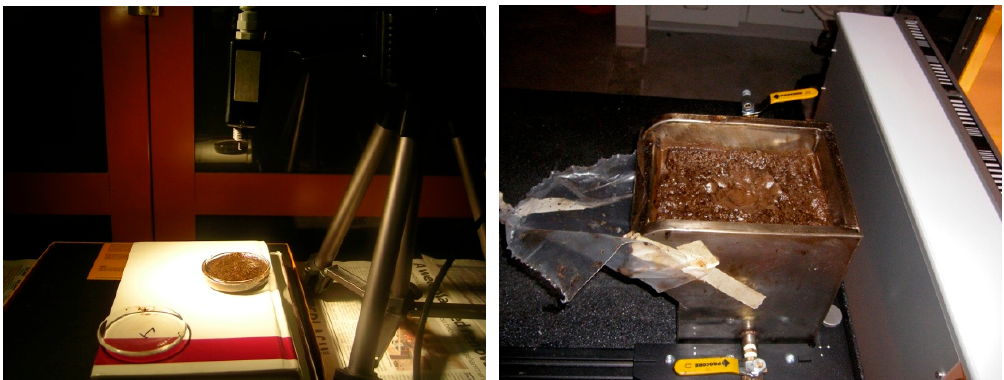
Figure 3. Acquisition of reflectance data. Left : acquisition of point spectra of froth residing in a glass jar as implemented in the initial flotation experiments for the first sample suite (Sp#1–Sp#10). Right : acquisition of hyperspectral imagery for froth residing in the flotation cell as implemented during the later stage flotation experiments for all samples.